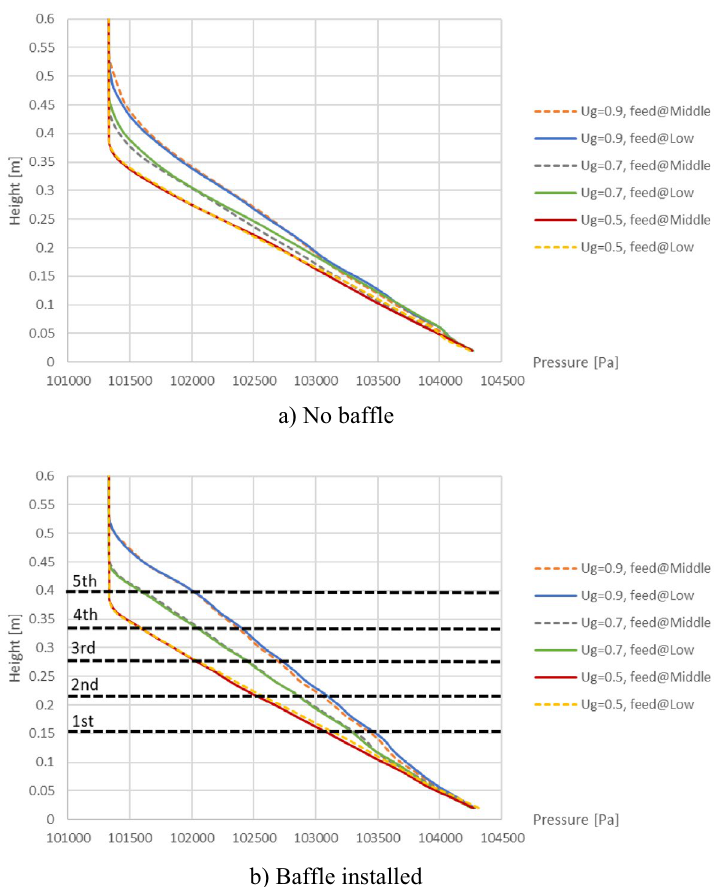
Figure 19. Comparison of time-and-area-averaged pressure when operating with different gas inlet velocities and different biomass feed